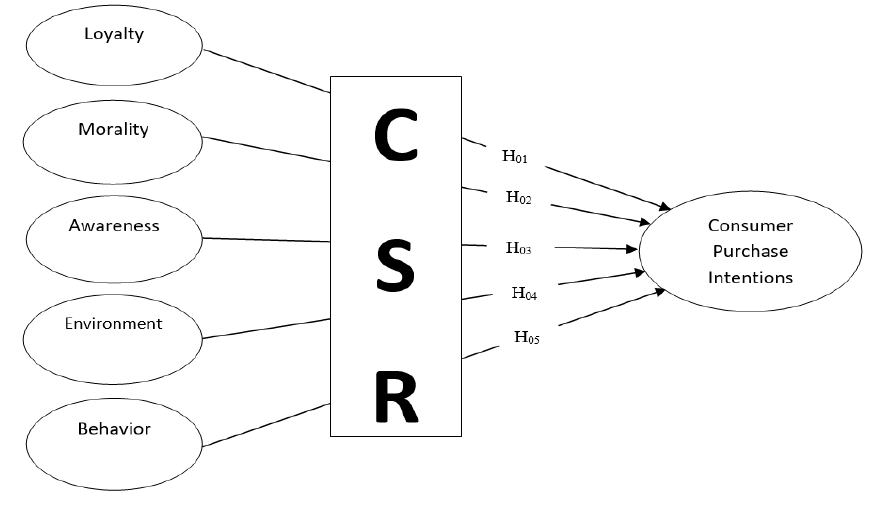
Fig. 1. Conceptual framework of influence of CSR on consumer purchase intention Source: Developed by the